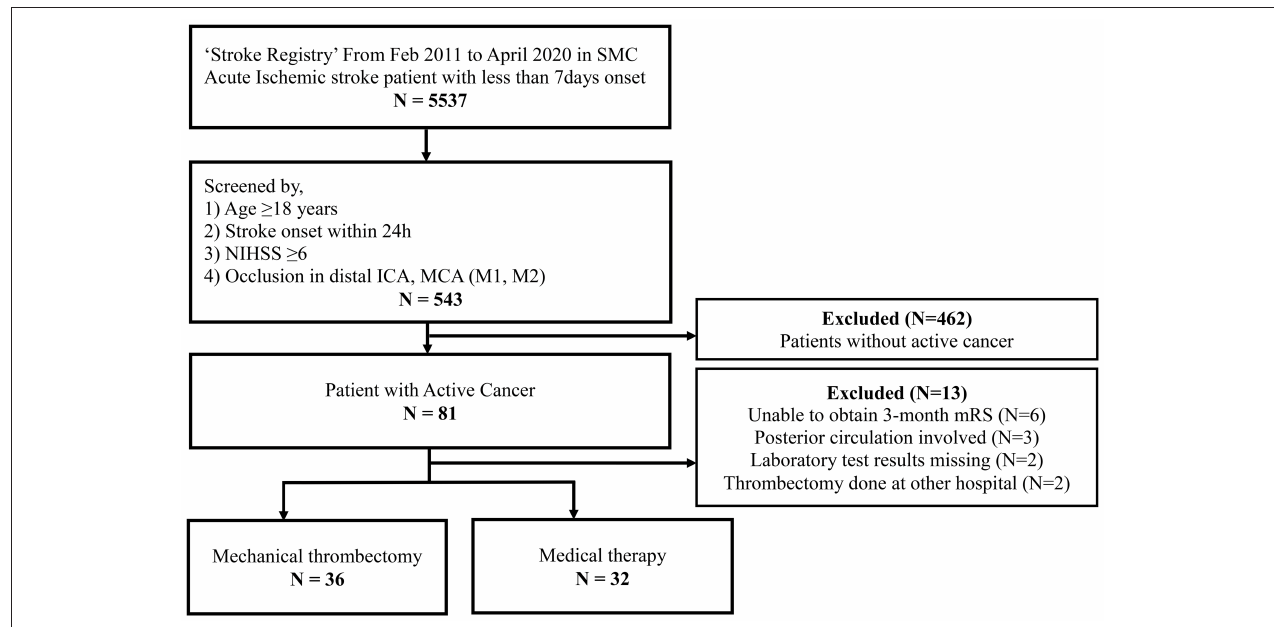
FIGURE 1 | Flow of patient inclusion.